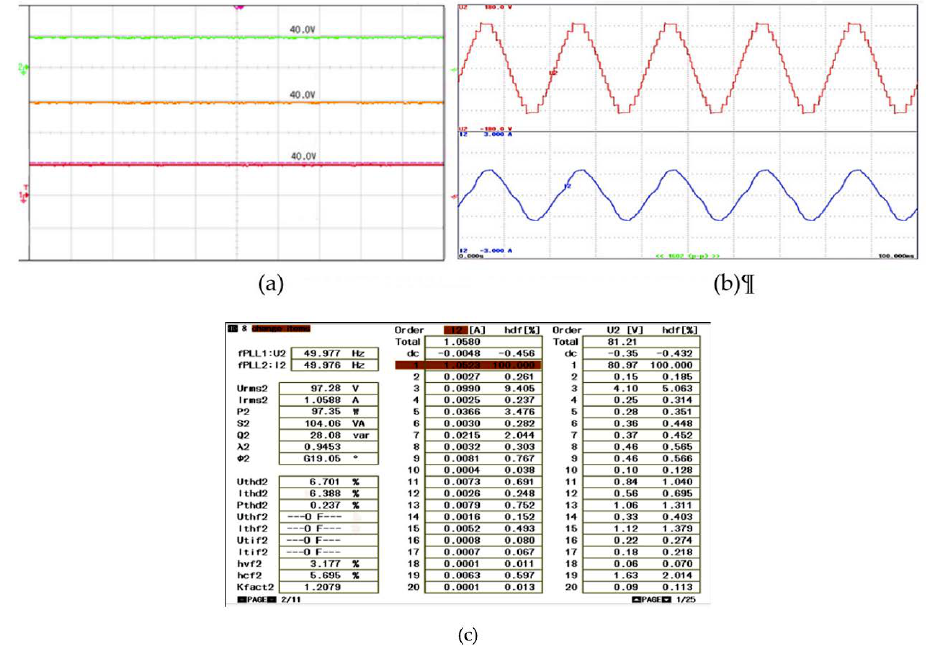
Figure 12. Experimental results of thirteen-level converter ( a ) capacitor voltages after balancing ( b ) output voltage and current waveform and ( c ) voltage harmonics.